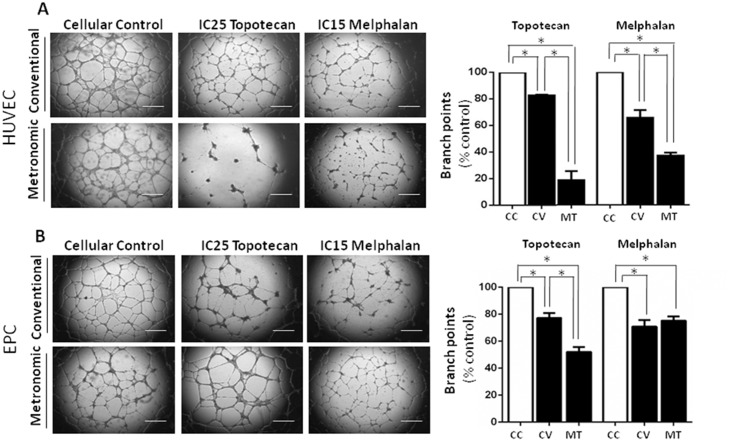
In vitro angiogenesis assay using Matrigel to characterize the antiangiogenic effect mediated by treatment scheme with topotecan and melphalan.Representative phase-contrast micrographs of tubular structures in cultured HUVEC (A) and EPC (B) previously exposed to conventional single-dose (upper row) or continuous treatment for 7 days (lower row) with topotecan at the IC25 (conventional IC25, 15nM; metronomic IC25, 0.5nM) or melphalan at the IC15 (conventional IC15, 5μM; metronomic IC15, 0.5μM), respectively. Magnification: 40X; Scale bar: 250μm. Experiments were performed in triplicate wells and five areas from each well were analyzed. The bar graph illustrates the significant decrease in the percentage of branch points after topotecan or melphalan used in a conventional or metronomic fashion compared to PBS-treated (control) cells or between treatment schedules. Data are shown as mean (SE) of three independent experiments; *p<0.05. Abbreviations: CC, control cells; CV, conventional treatment; MT, metronomic treatment.